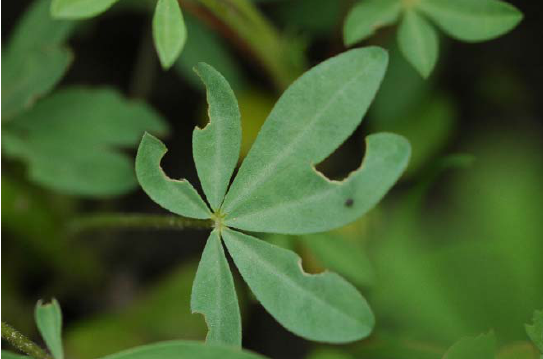
Figure 3. Lupin leaf U ‐ shaped feeding notches.